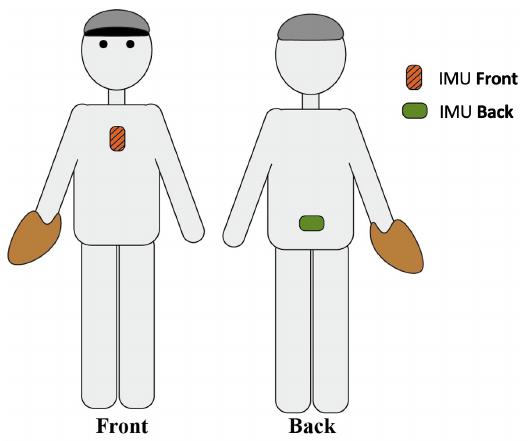
Figure 1. Placement of the